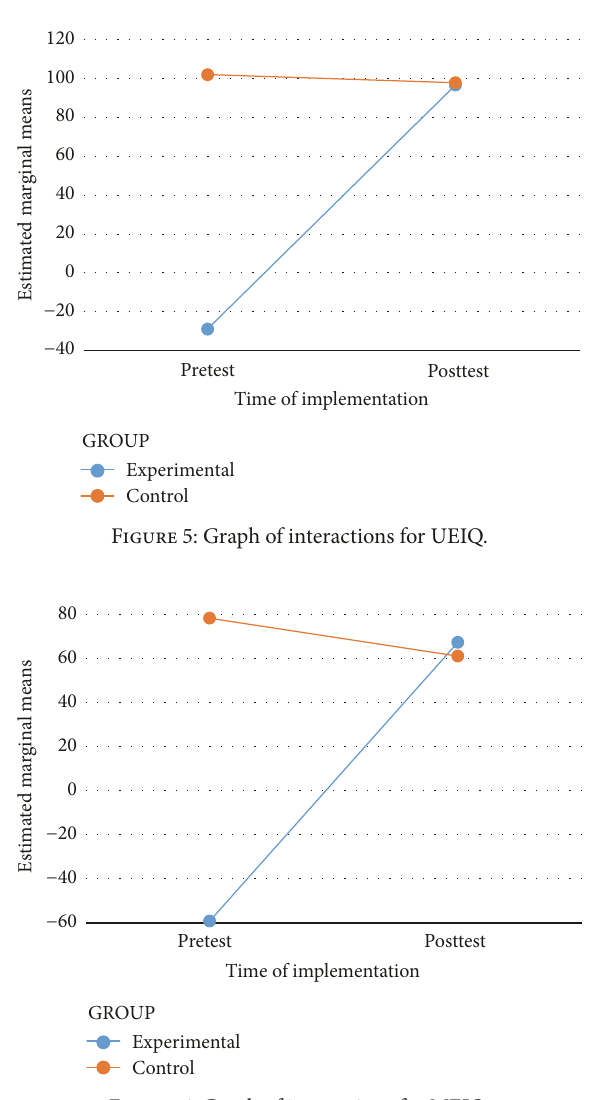
Figure 6: Graph of interactions for